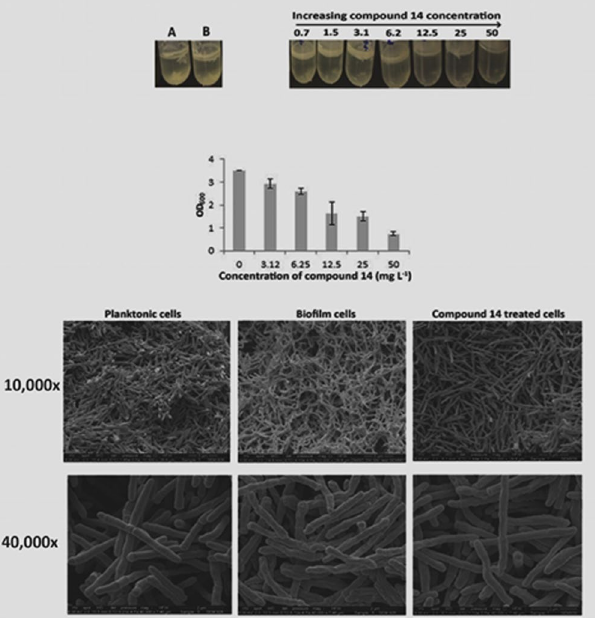
Figure 3. Inhibition of M . smegmatis biofilm formation in the presence of varying concentrations of compound 14 . ( a ) Dose-dependent inhibition of M . smegmatis biofilm formation, as observed by their thinning in the presence of compound 14 . Tubes A and B are ‘no drug’ and solvent (0.1% DMSO) controls respectively. Note that the biofilm formation initiated at the air-liquid interface in M . smegmatis . A newly-formed biofilm becomes stacked on top of the old layer and generates a downwards push. Once a critical biomass was exceeded, the lower part of the mature biofilm was observed to dissociate and settle at the bottom of the stand-culture-tube (see controls in which no inhibitor was added). ( b ) Crystal violet staining of the biofilms showing a decrease in the intensity of the stain with increasing concentrations of compound 14 . ( c ) SEM images of M . smegmatis planktonic, untreated biofilms and biofilms treated with 50 mg L − 1 of compound 14 .